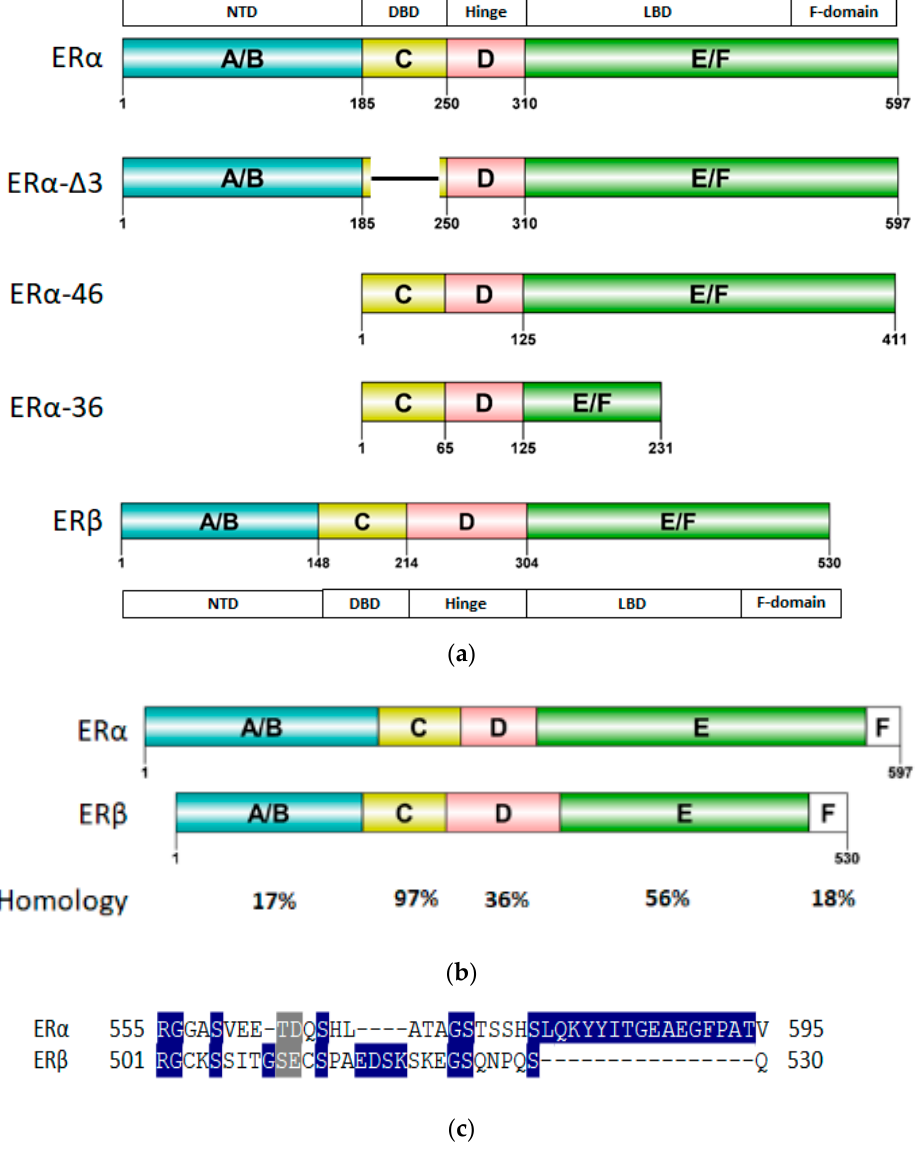
Figure 2. ( a ) ER α and ER β domain organization; ( b ) homology of ER α and ER β at different domains; and ( c ) F-domain sequence alignment between ER α and ER β